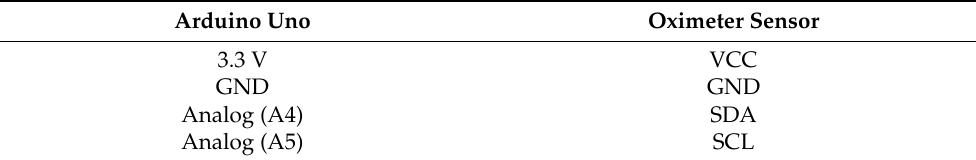
Table A2. Arduino Uno pin connection.